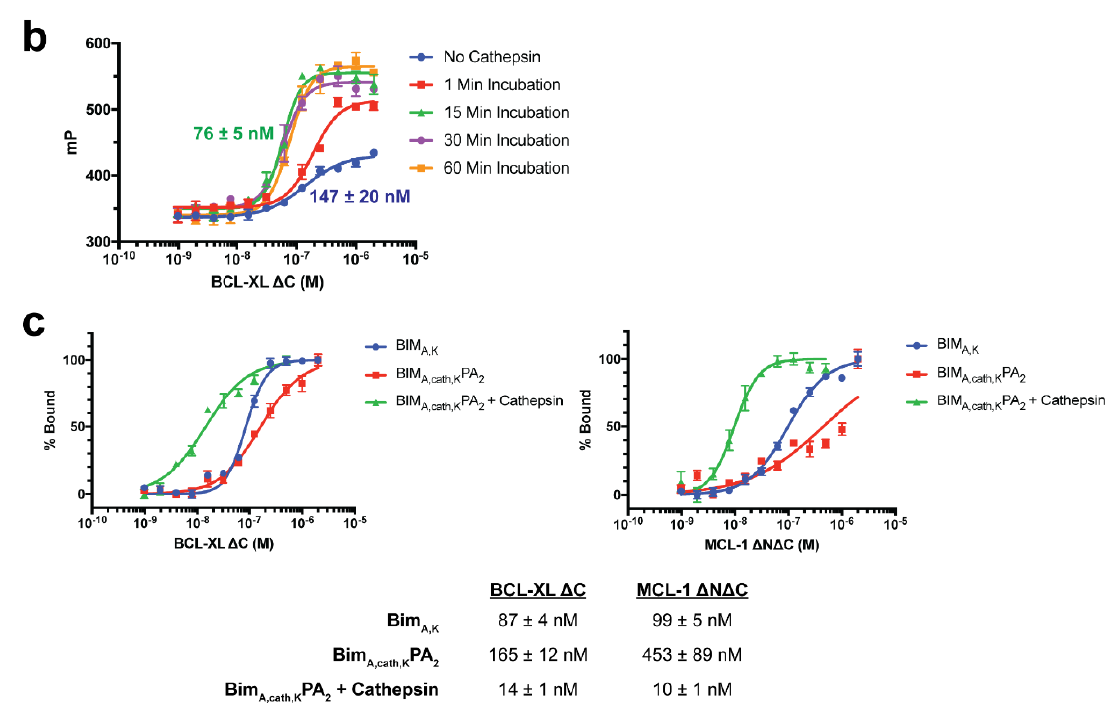
Figure 4. Removal of the C-terminal lipid tail and lysines of BIM A,cath,K PA 2 enhances binding to antiapoptotic BCL-2 family targets. ( a ) FITC-labeled peptide and PAs were incubated with serial dilutions of recombinant BCL-2, BCL-XL, BCL-W, and MCL-1, and affinity profiles were measured by fluorescence polarization (FP). K d values are listed as the mean of replicates ± S.E.M. ( b ) BIM A,cath,K PA 2 pre-incubated with recombinant cathepsin B improved binding to recombinant BCL-XL in a time-dependent manner. ( c ) BIM A,cath,K PA 2 pre-incubated with cathepsin B followed by enzyme-inactivation resulted in increased BIM A peptide affinities to recombinant BCL-XL ∆ C and MCL-1 ∆ N ∆ C. Plotted data and K d values are the mean of replicates ± S.E.M.